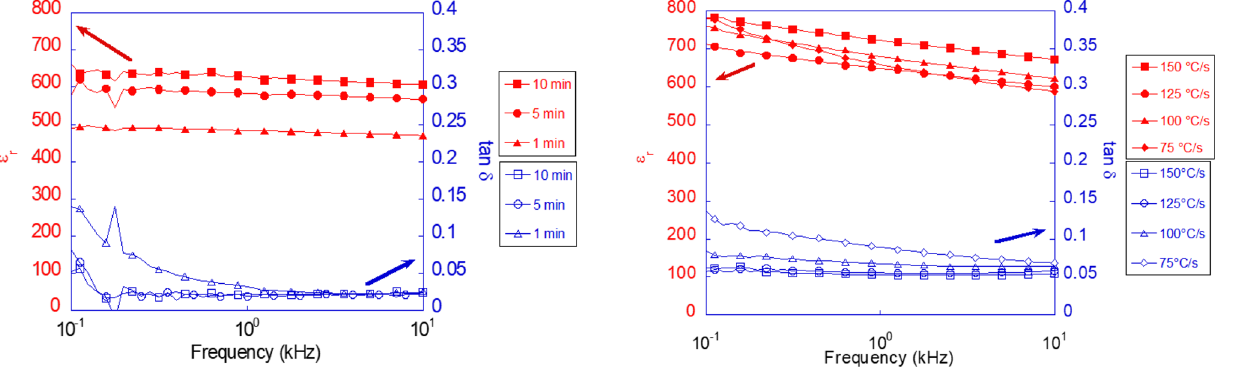
Fig. 4 Dielectric constant (ε ) and dielectric loss (tan δ ) vs. fre- r quency for 210 nm films annealed at 700 °C for 5 min with 75 °C per second, 100 °C per second, 125 °C per second, and 150 °C per sec- ond ramp